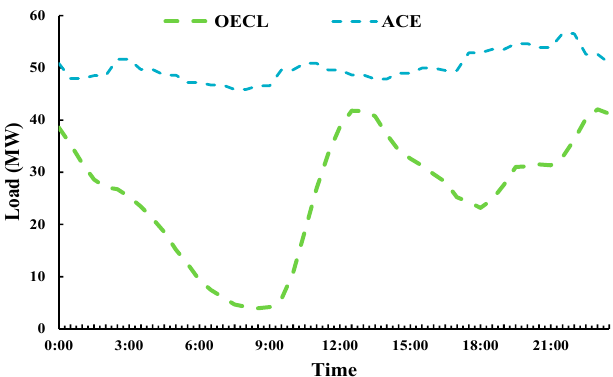
Figure 14. The average profile of the ACE and the OECL with projected EV and load growth.